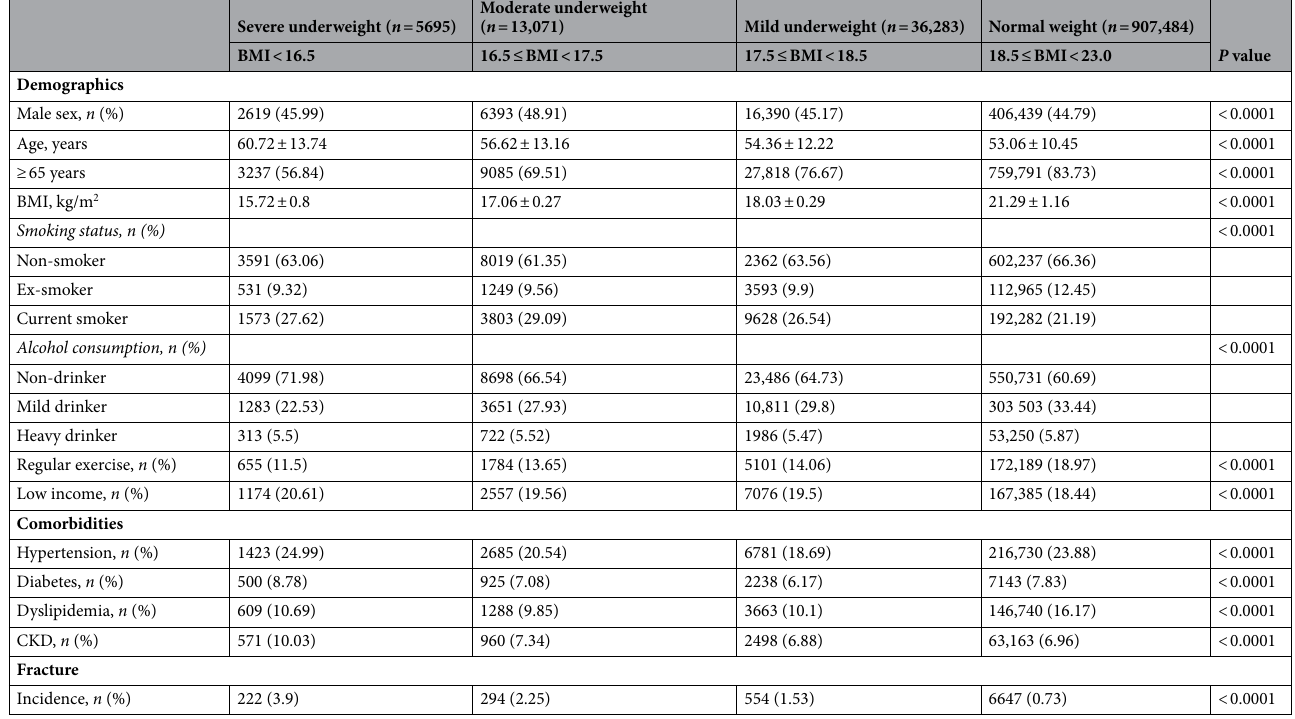
Table 1. Baseline characteristics of participants according to the degree of underweight. BMI body mass index, CKD chronic kidney disease.